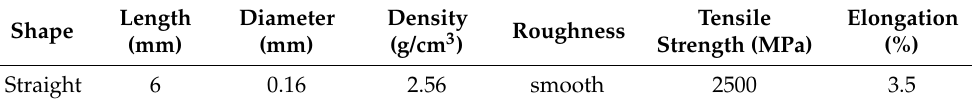
Table 6. Properties of steel fiber.